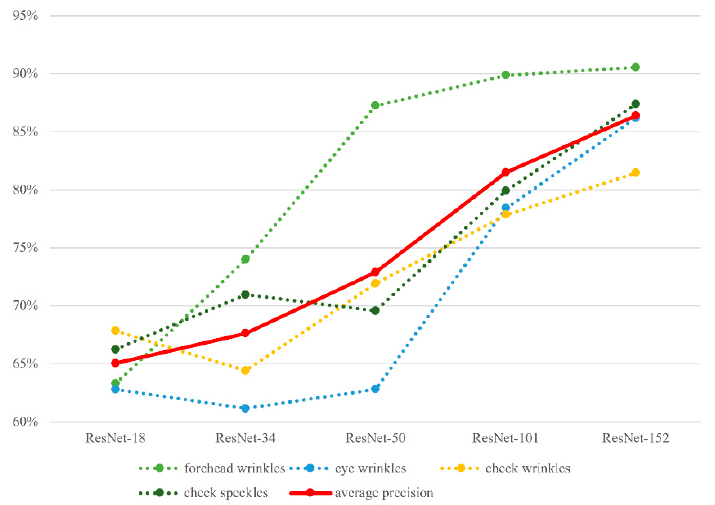
Figure 13. Model accuracy results (from K-fold cross validation) plotted against model layers and facial features.